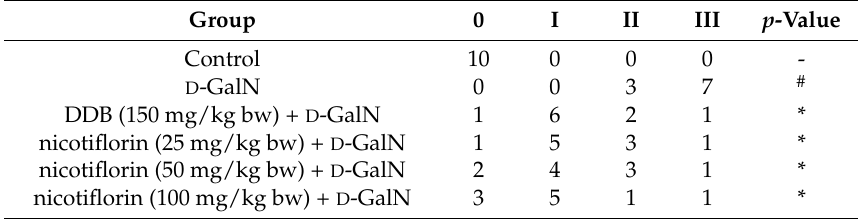
nicotiflorin (50 mg/kg bw) + D -GalN